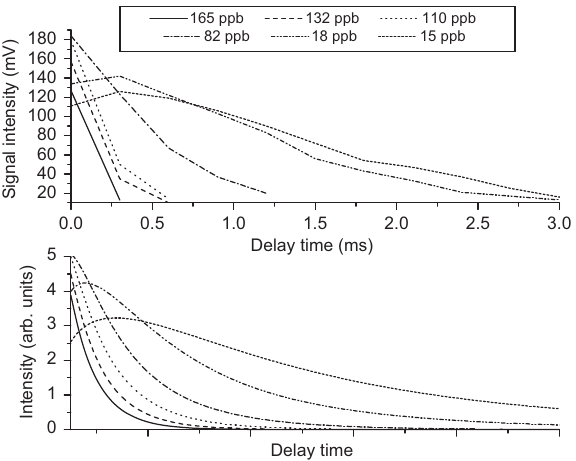
Figure 5 Comparison of measured (upper graph) and calculated (lower graph) signal intensities for a monomer signal (measure- ments shown for ethyl methyl